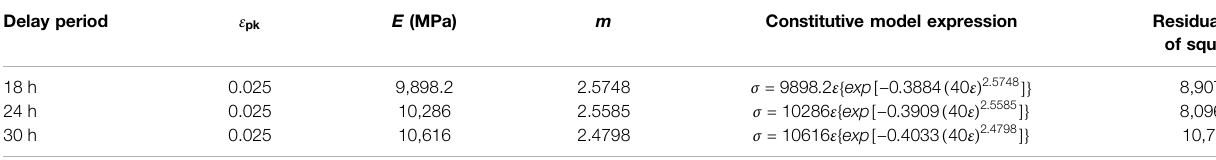
TABLE 5 | Parameters of constitutive model of RPC under uniaxial compression.